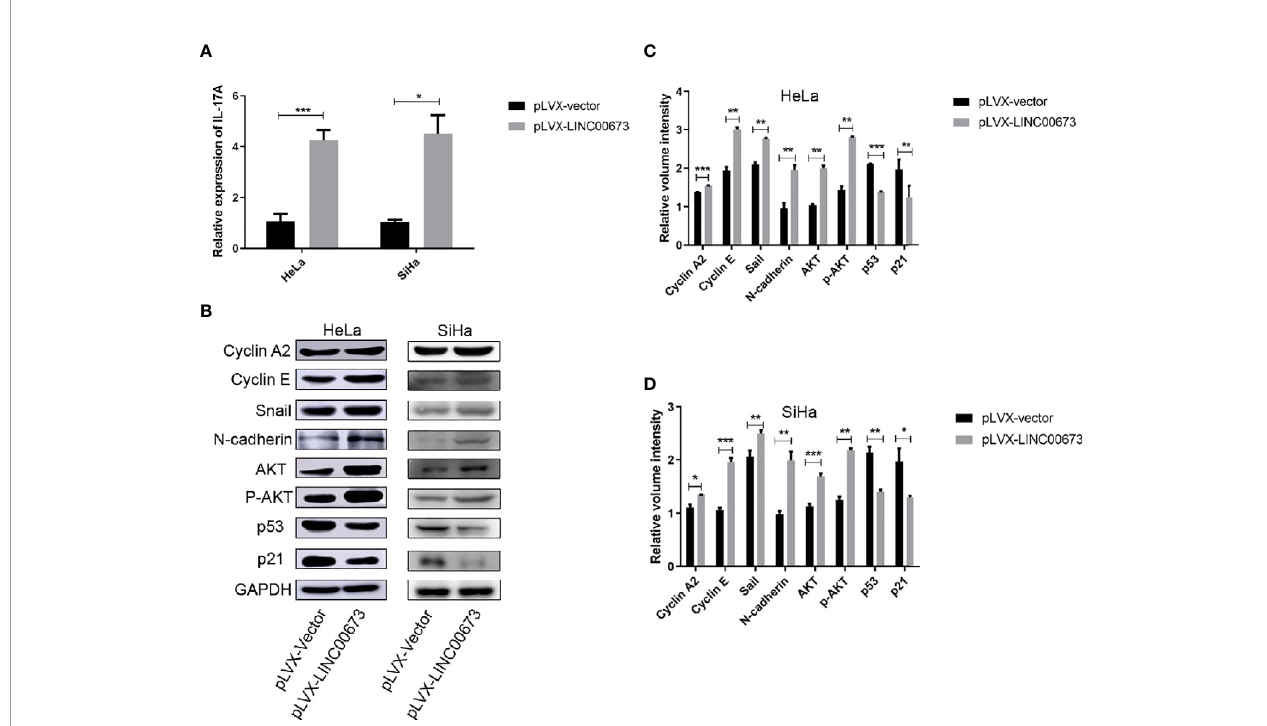
FIGURE 4 | LINC00673 induces IL-17A mRNA and activates AKT-related proteins. (A) RT-qPCR results showed that LINC00673 overexpression promoted IL-17A mRNA expression in HeLa and SiHa stable cell lines. (B) Detection of AKT-related proteins in LINC00673-overexpressing and control HeLa and SiHa stable cell lines by western blot. GAPDH was used as the loading control. (C, D) Bar charts show quanti fi cation of the western blot results in (B) . Data are presented as mean ± SD (N = 3); * P < 0.05, ** P < 0.01, *** P < 0.001. Student ’ s t